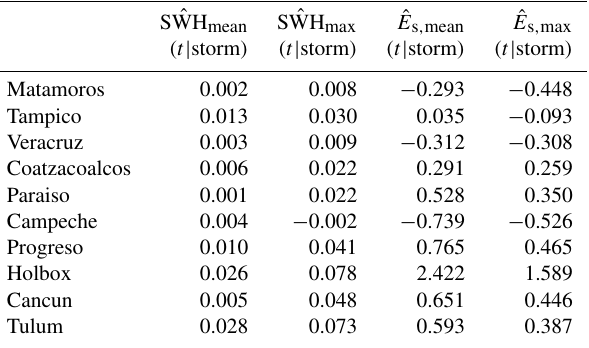
Table 4. Trends obtained for the time series, excluding years with no events related to TCs.